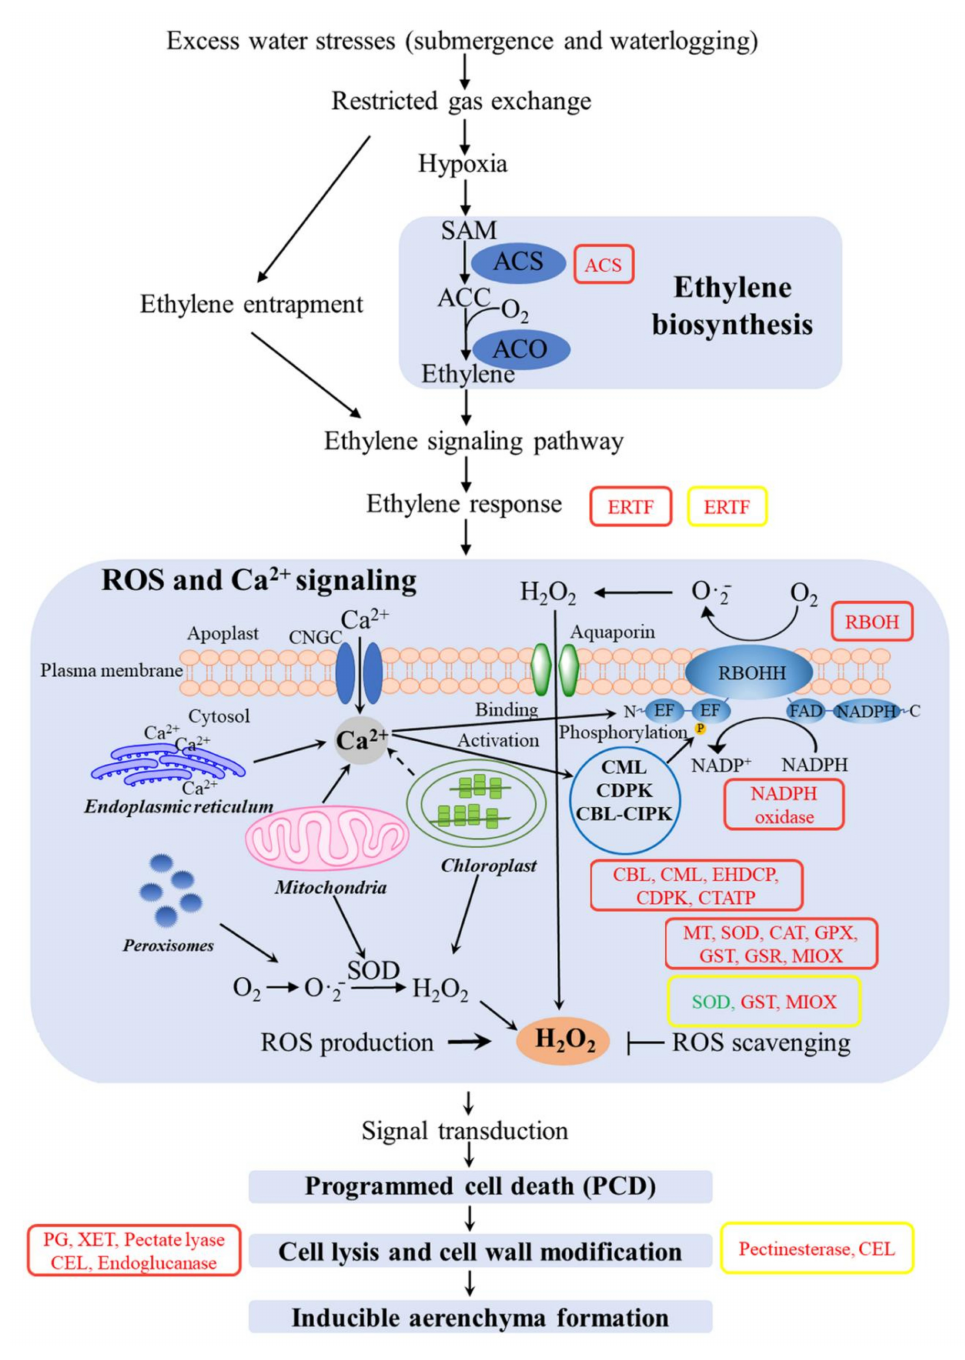
Figure 10. The expression of differentially expressed genes (DEGs) related to aerenchyma formation in underground tissues of bermudagrass under shallow submergence (SS) (Red box) and deep submergence (DS) (Yellow box). Red letters represent up-regulated expression; green letters represent a down-regulated expression. ACS: 1-aminocyclopropane- 1-carboxylic acid synthase; ERTF: ethylene-responsive transcription factor; RBOH: respiratory burst oxidase homolog; CBL: calcineurin B-like protein; CML: calcium-binding proteins and calmodulin-like protein; EHDCP: EH domain-containing protein; CDPK: calcium/calmodulin-dependent protein kinases; CTATP: ca 2+ -transporting ATPase; MT: metallothionein; SOD: superoxide dismutase; CAT: catalase; GPX: glutathione peroxidase; GST: glutathione S-transferase; GSR: glutathione reductase; MIOX: myo-inositol oxygenase; PG: polygalacturonase; XET: xyloglucan endotransglucosylase; CEL: